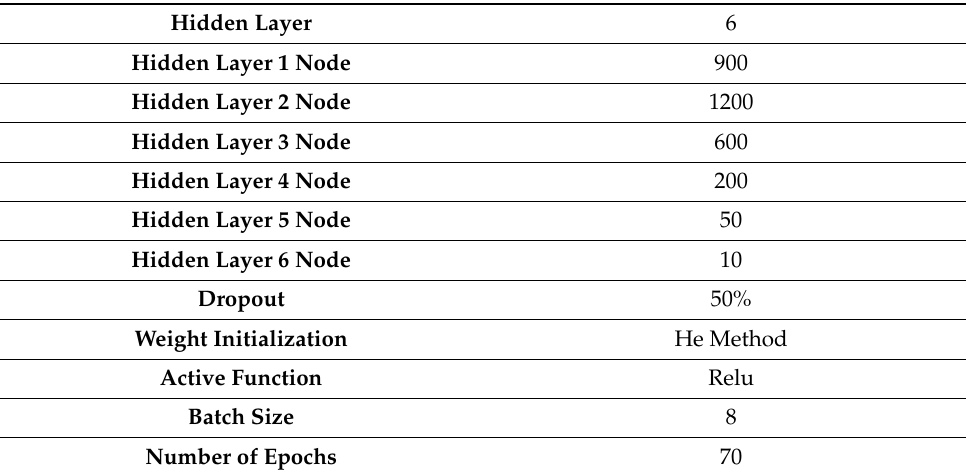
Table 4. Hyperparameter applied to training.